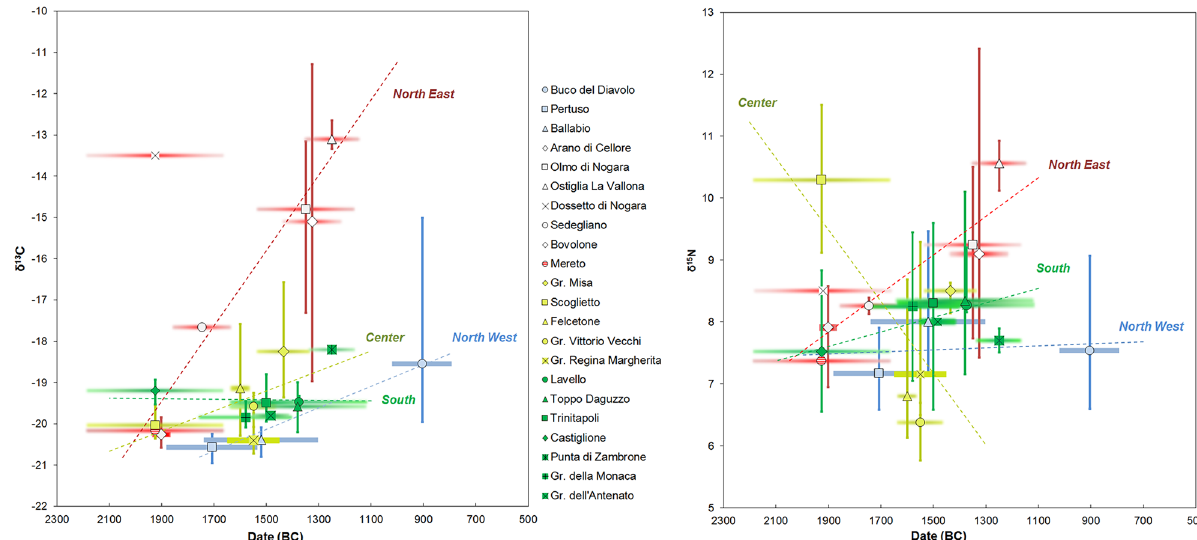
Figure 6. Distribution of δ 13 C (left) and δ 15 N (right) human group medians according to their chronology. Horizontal bars with blurred strokes indicate the absence of absolute dates. Horizontal well-defined lines indicate chronological periods determined through radiocarbon dates. Regression lines are calculated and weighted according to the number of individuals for each site: n = 1, w = 0.25, n = 2–3, w = 0.5, n > 3, w =